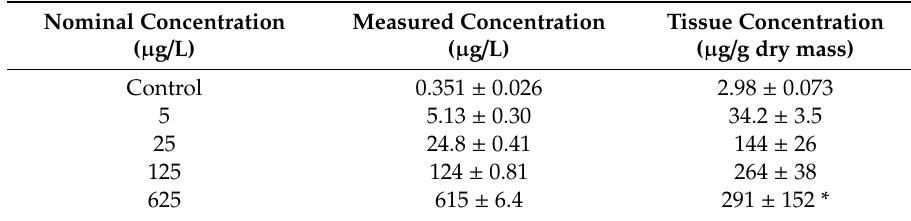
Table 1. Total Se concentration in test solutions (mean ± SE, n = 9–10) and pooled (35–180 larvae; n = 3) Danio rerio larvae (5 days post fertilization).